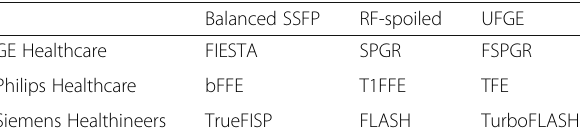
Table 1 Manufacturer acronyms of gradient echo sequences used for real-time joint dynamic MRI Balanced SSFP